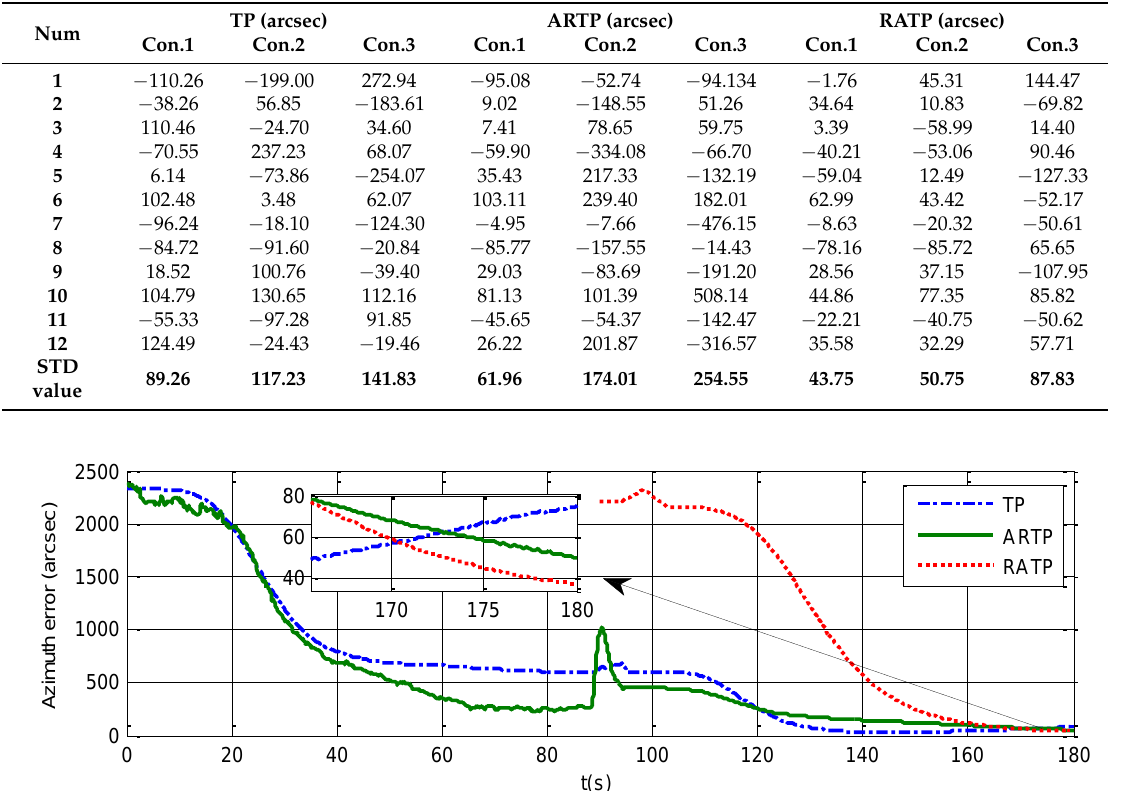
Table 4. Azimuth error under different conditions for 180 s rapid alignment.